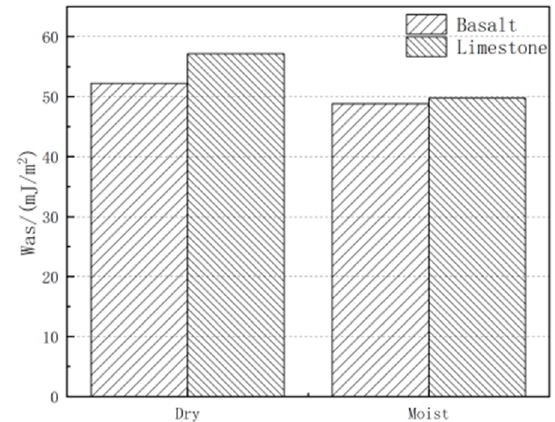
Figure 14. Influence of water on adhesion work of CR.